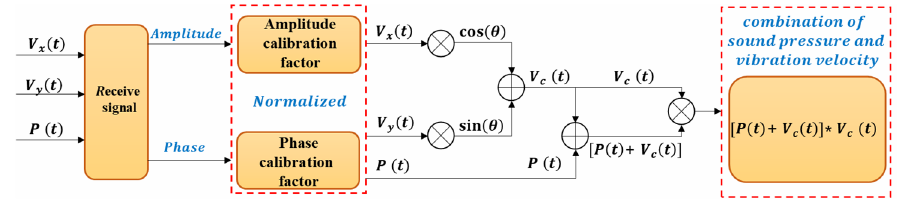
Figure 11. Principle block diagram of beamforming algorithm.